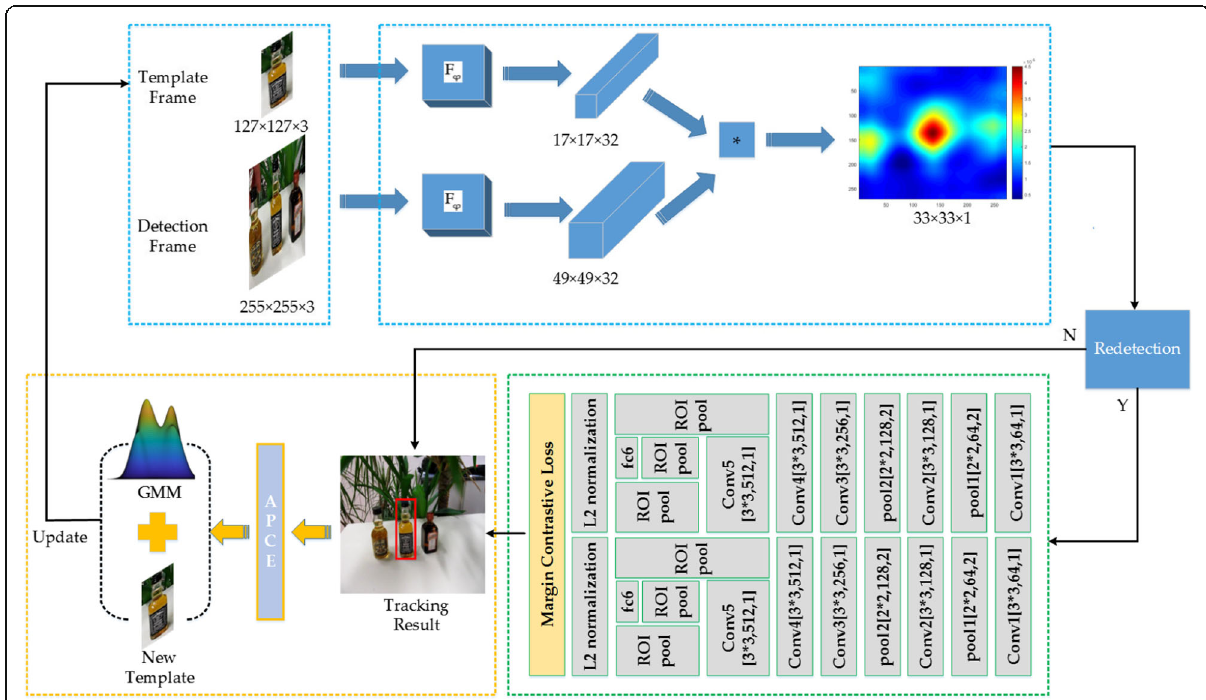
Fig. 2 The flow chart of the Siam-RM framework. The fully-convolutional Siamese network is utilized to get the response map. If the secondary peak in the response map is 0.75 times larger than the main peak in the map, the re-detection network will be initiated. The APCE and the GMM model achieve the goals to construct robust templates and update them adaptively